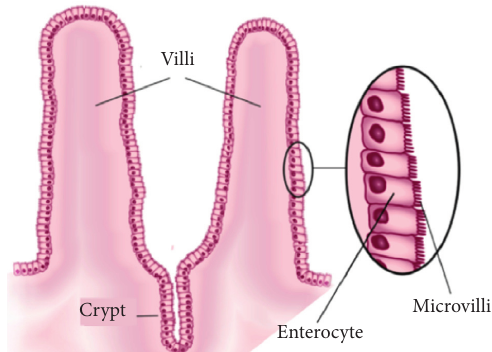
Figure 13: Ultrastructure of the small intestine